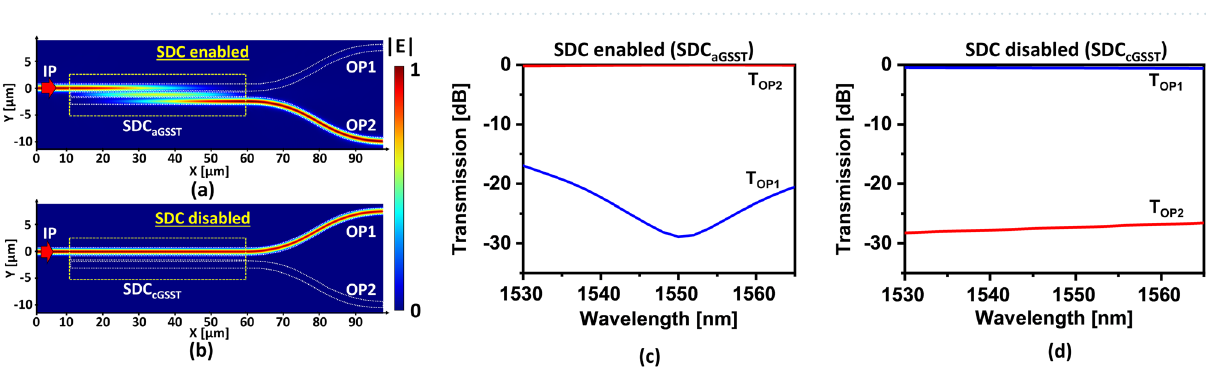
Figure 3. ( a ) Calculated supermode profiles of the SDCs overlaid with aGSST (i)–(iii) and cGSST (iv)–(v). ( b ) Corresponding effective refractive indices of the supermodes in terms of the width w 2 . ( c ) Calculated coupling length L aGSST and ratio of L cGSST to L aGSST with respect to the gap (w gap ).